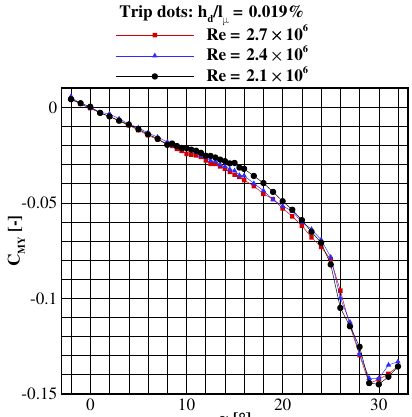
Figure 8. Reynolds number effect on the pitching-moment coefficient as function of angle of attack—case with trip dots h d / l µ = 0.019%.